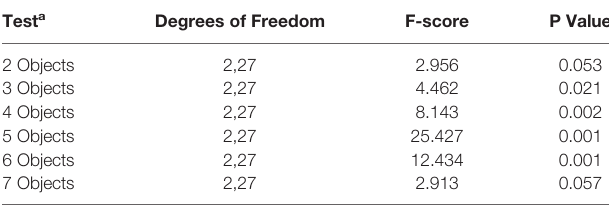
TABLE 3 | MANOVA results for memory load preference scores.